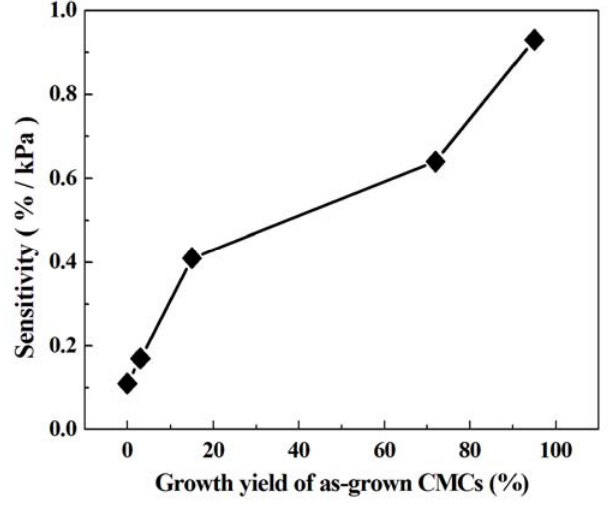
Figure 6. Sensitivity of CMC pressure sensor vs . the growth yield of as-grown CMCs.